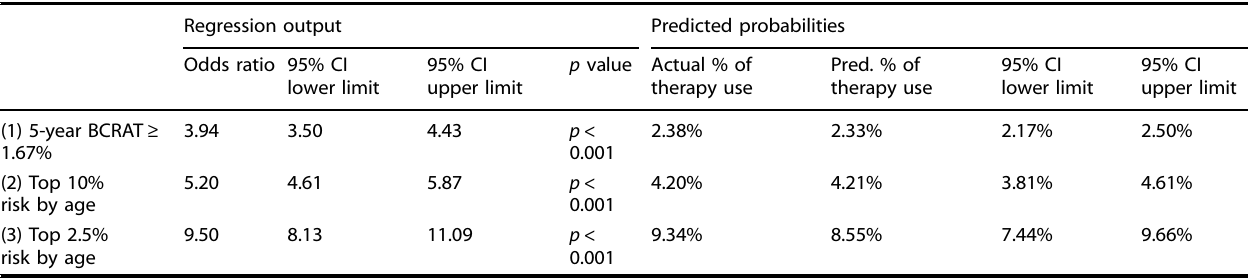
Table 4. Logistic regression analysis of risk-reducing therapy use in Athena